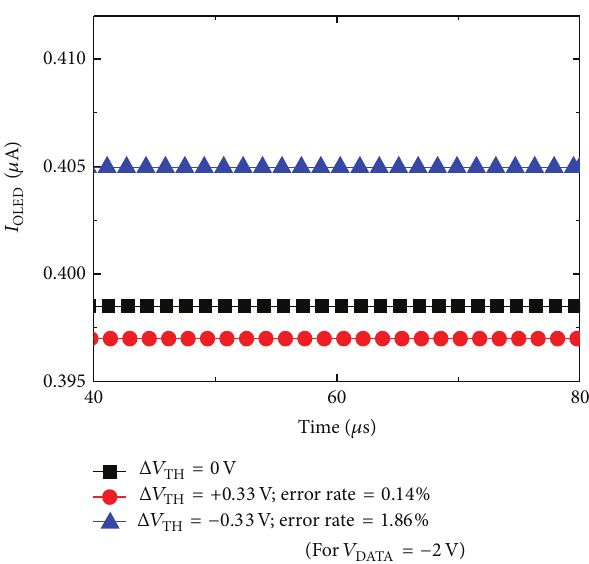
Figure 5: The OLED current with the variation in the threshold = −2 voltage of DTFT when 𝑉 DATA